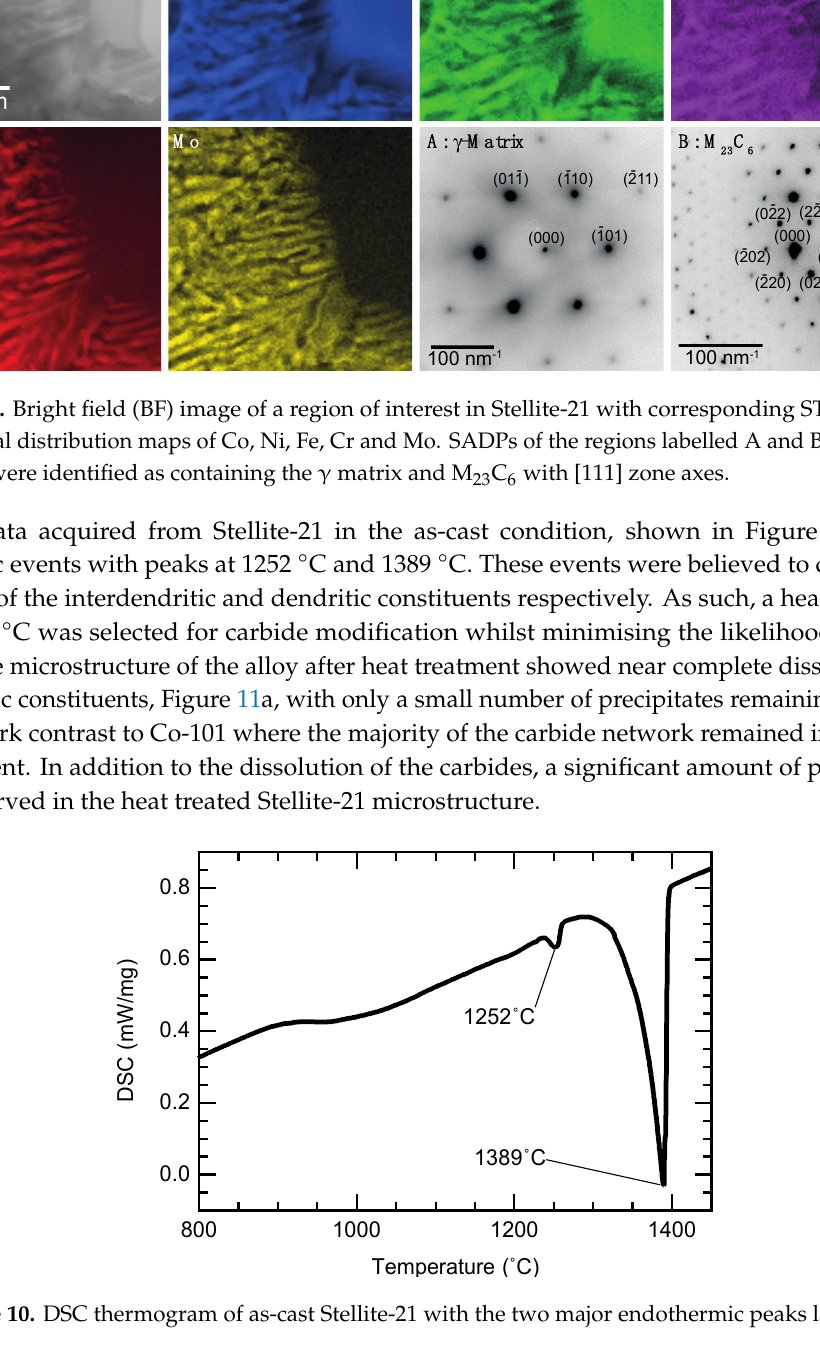
Figure 10. DSC thermogram of as-cast Stellite-21 with the two major endothermic peaks labelled.